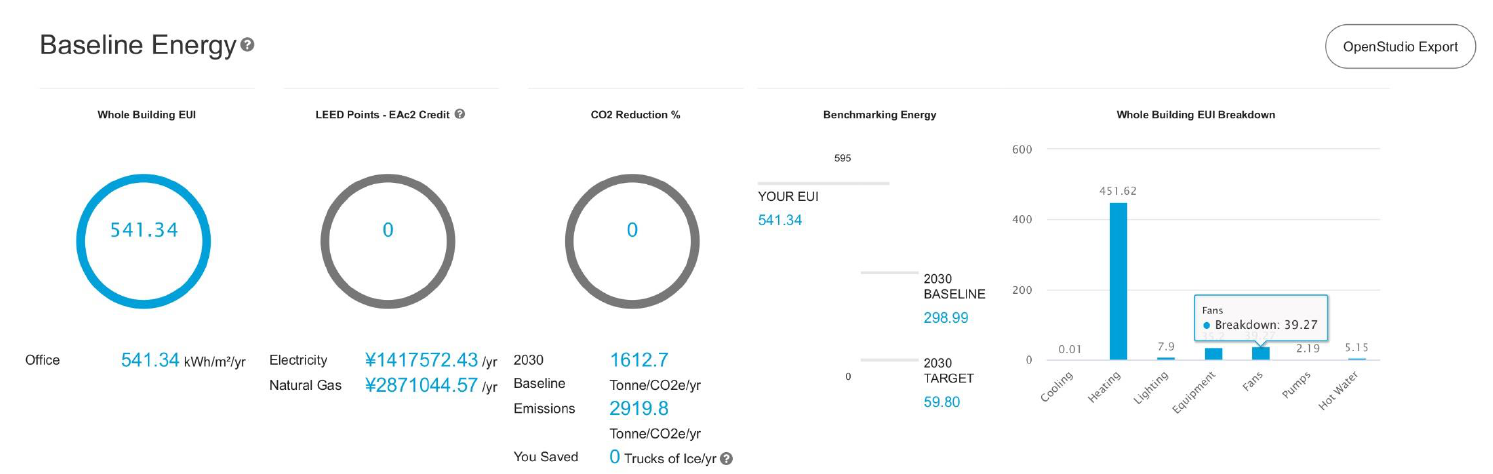
Figure A37. Zone 6-H Xi’ning, Qinghai (pre-COVID-19 scenario). Figure A37. Zone 6- H Xi’ning, Qinghai (pre-COVID-19 scenario).